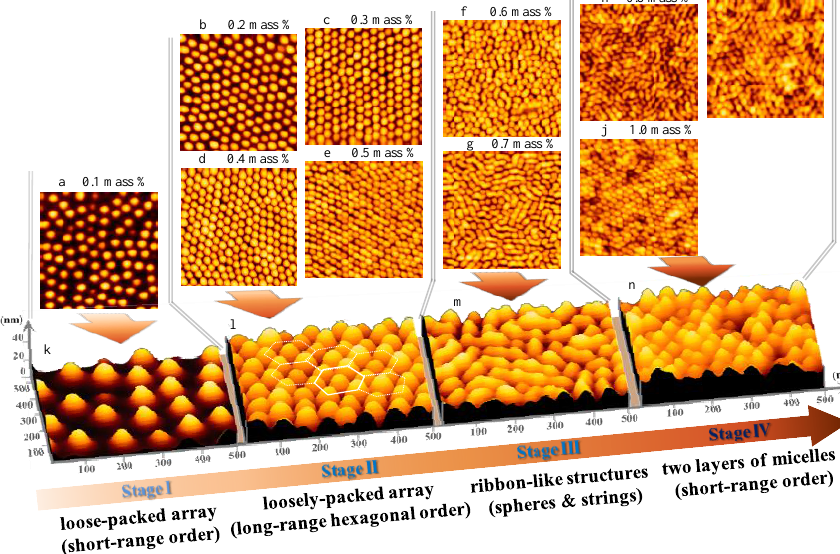
Figure 1. 1 μm × 1 μm atomic-force microscope (AFM) topographies for micelles on SiO x /Si spun from toluene solutions containing polystyrene- b -poly(2-vinylpyridine), P(S- b -2VP), micelles at weight fractions: ( a ) 0.1; ( b ) 0.2; ( c ) 0.3; ( d ) 0.4; ( e ) 0.5; ( f ) 0.6; ( g ) 0.7; ( h ) 0.8; ( i ) 0.9 and ( j ) 1.0 wt %. Images ( k – n ), respectively, represents the three-dimensional (3D) topographies of two-dimensional (2D) images ( a , d , g , j ).